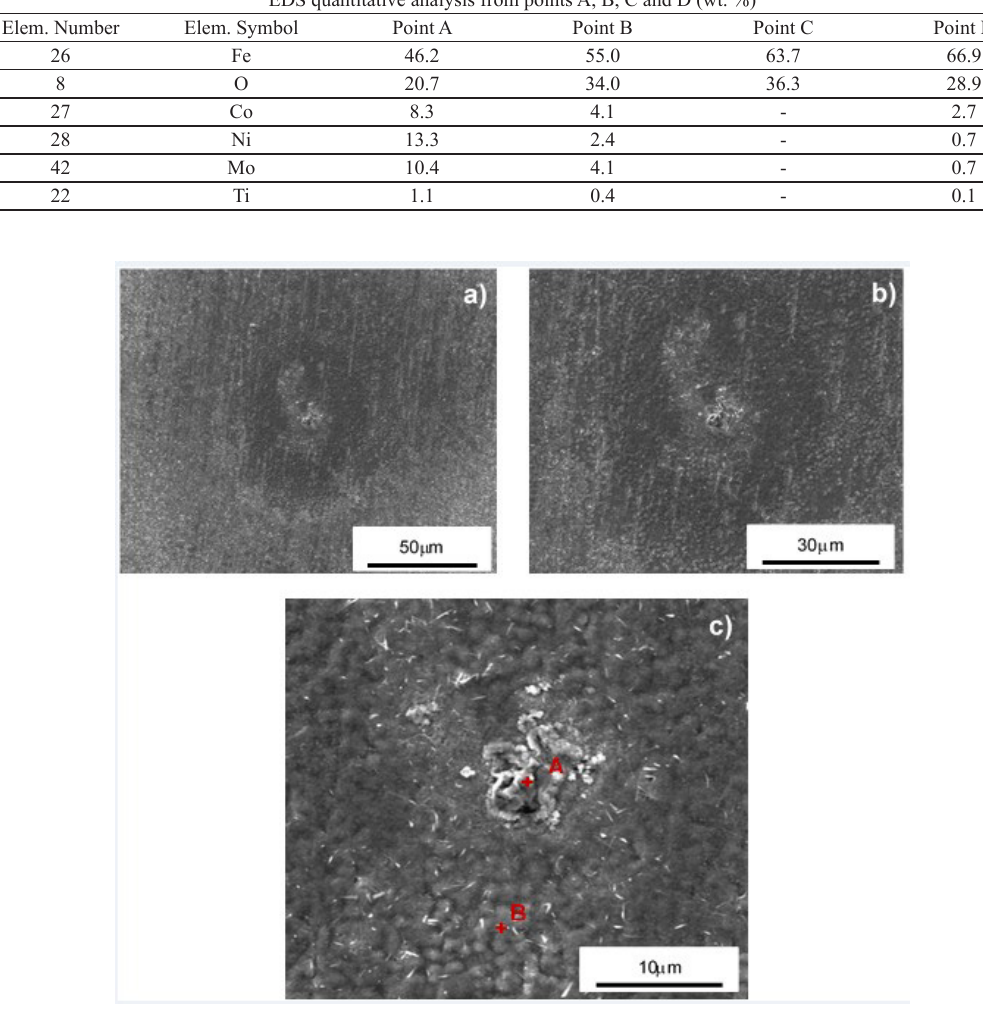
Figure 10. SEM micrographs of the oxide layer growth under O